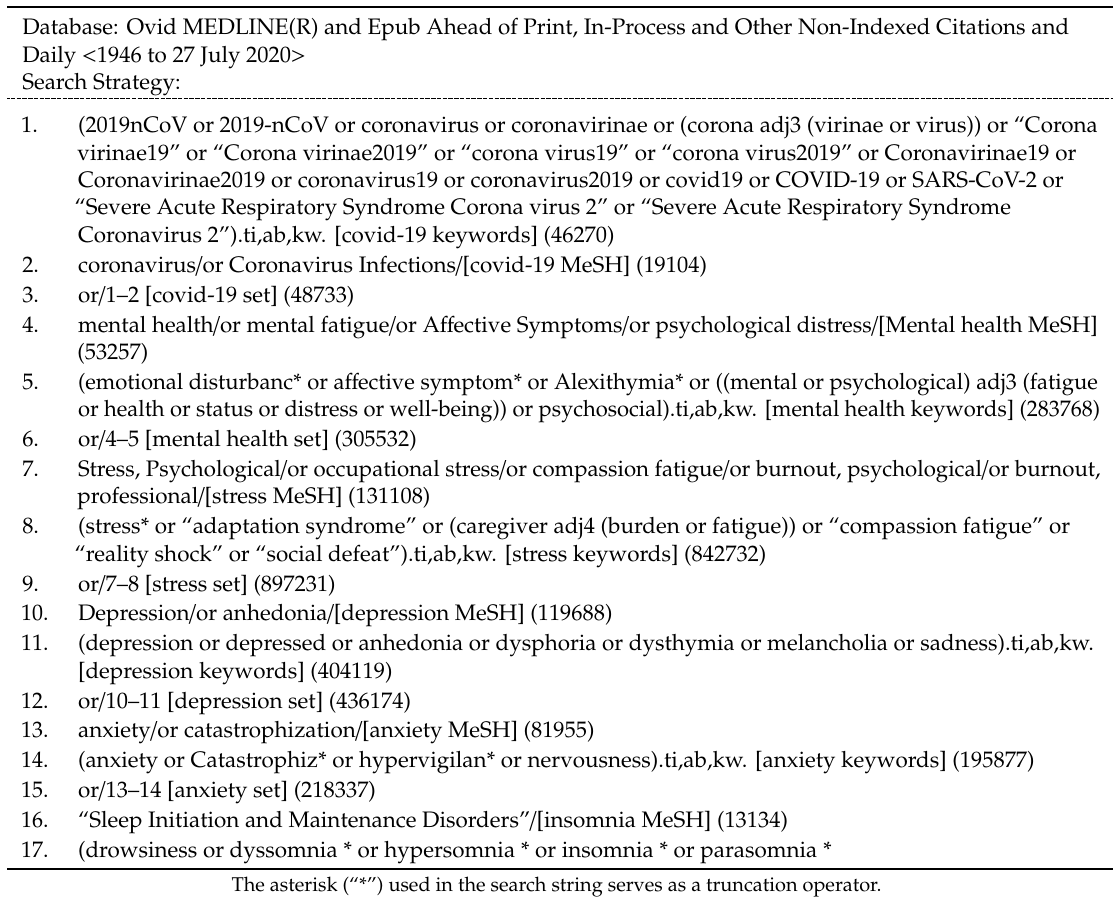
Table A1. Database search strategies for psychological impact of COVID-19 among healthcare